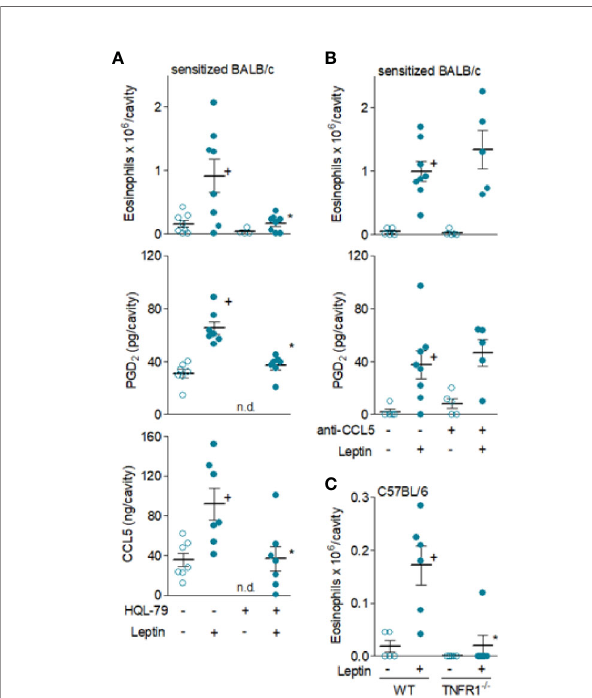
FIGURE 5 | Leptin-induced in vivo eosinophil migration is mediated by PGD 2 and TNF a , but not by CCL5. In (A, B) , sensitized BALB/c mice received i.pl. injection of leptin (1 mg/kg) and pleural fl uids were collected within 24 h. While in (A) , animals were pre-treated with HQL-79 (1 mg/kg, i.p.), in (B) mice were pre-treated with a neutralizing anti-CCL5 antibody (10 µg/cavity, i.pl.). In (C) , naïve wild type or TNFR1 de fi cient C57BL/6 mice received i.p. injection of leptin (1 mg/kg) and peritoneal fl uids were collected within 24 h of stimulation. As indicated, analyses include pleural eosinophil counts evaluated in cells stained by May-Grünwald-Giemsa as well as PGD 2 and CCL-5 levels found in cell-free pleural fl uids measured by speci fi c EIA and ELISA kits (middle panels). Values are expressed as the mean ± SEM (experiments were repeated at least once). + p < 0.05 compared to control group and * p < 0.05 compared to leptin-stimulated group. n.d.; not